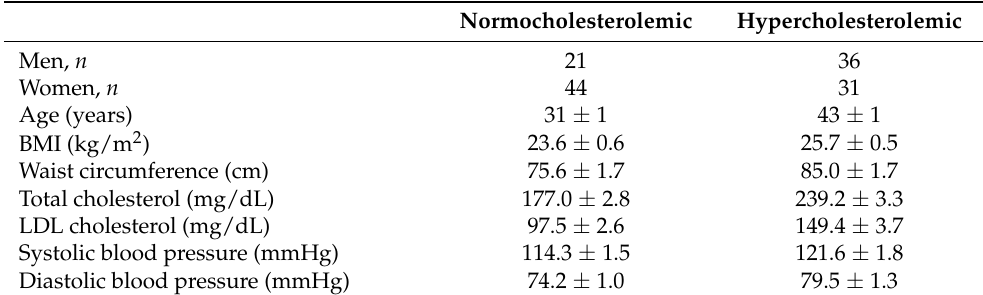
Table 1. Baseline characteristics of participants in both